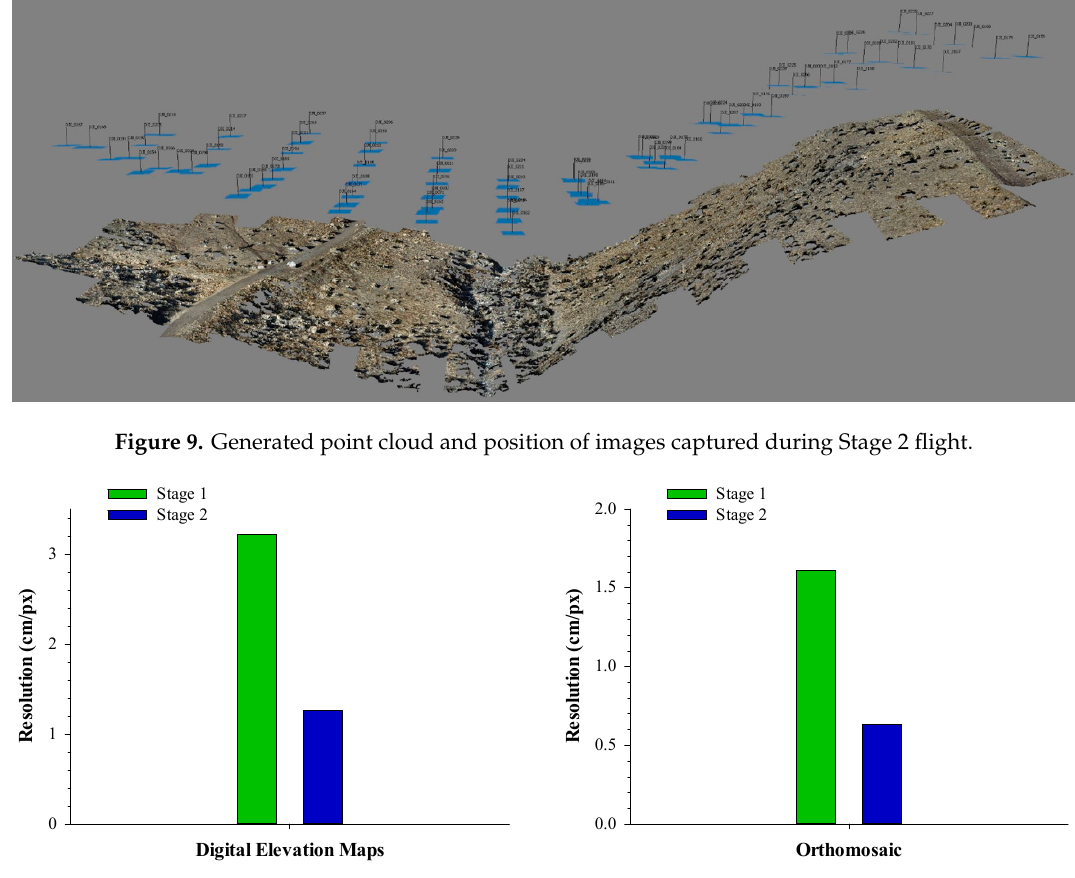
Figure 8. High-resolution flight planning using the developed application.